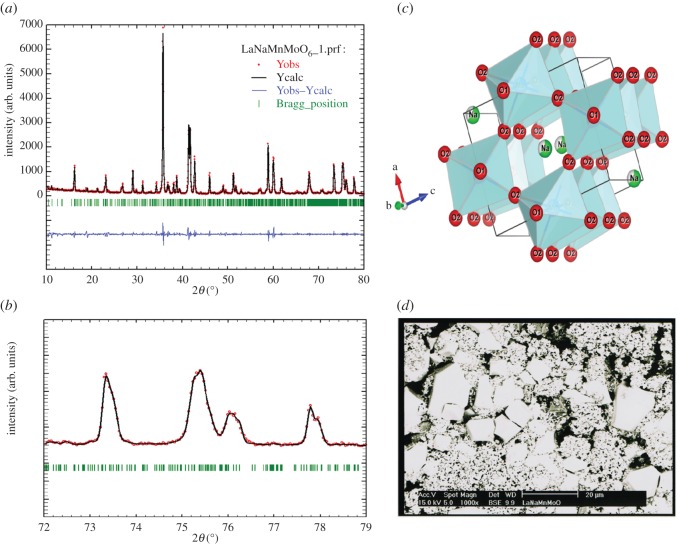
Typical powder X-ray diffraction (XRD) profile (a), the fit between the observed and the calculated profiles (b), the schematic view of the orthorhombic crystal structure (c), and the SEM images (d) of the LaNaMnMoO6 sample. Dots and solid line represent the observed and calculated profiles, respectively. The difference plot is drawn below the profile, and vertical bars represent the allowed reflections.